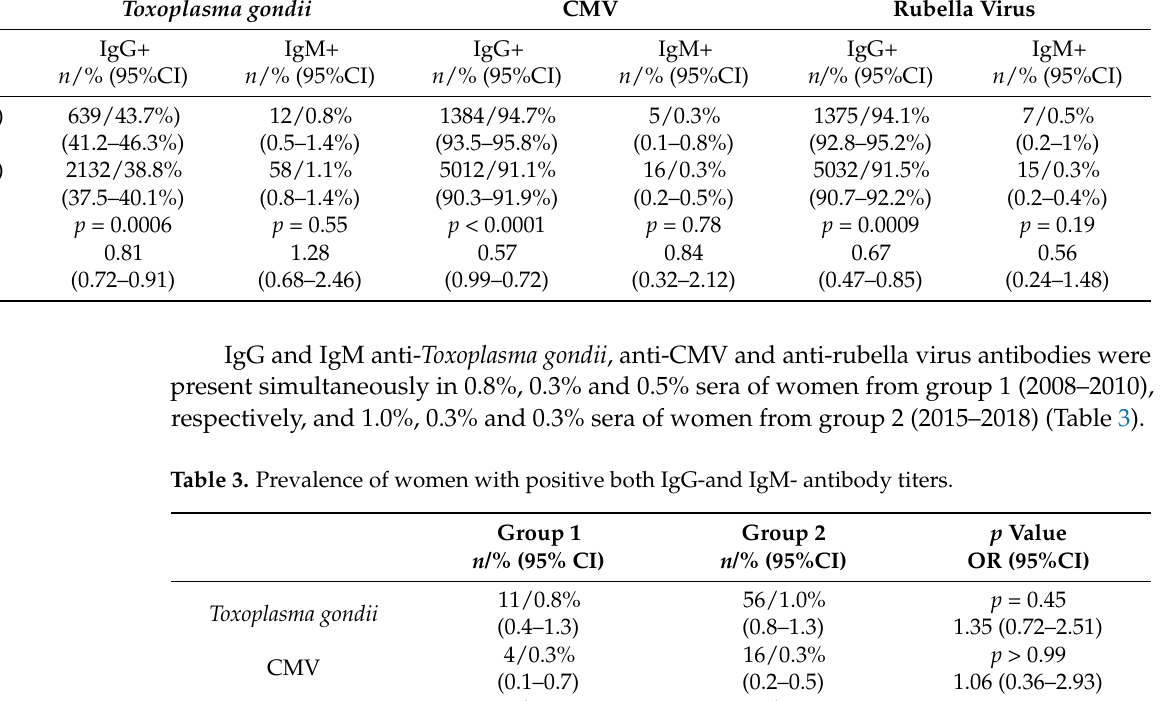
Table 2. IgG- and IgM-anti- Toxoplasma gondii , -CMV and -rubella virus seroprevalence: (2008–2010) and (2015–2018). Toxoplasma gondii CMV Rubella Virus